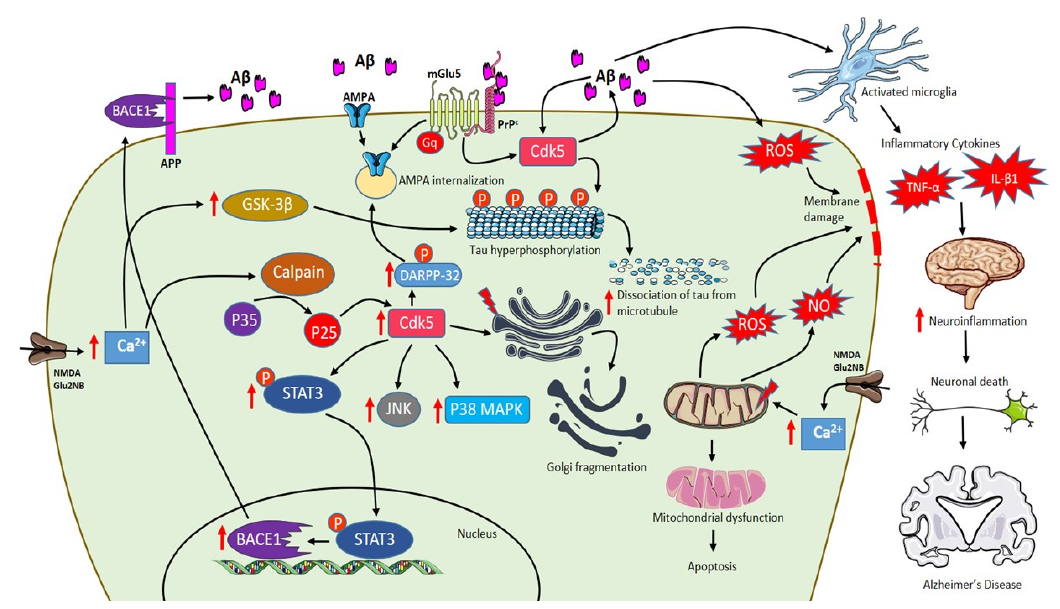
Figure 2. Schematic representation of AD pathophysiology involving A β , extrasynaptic NMDA Glu2NB, mGlu5 and role of activated microglia. Activation of NMDA Glu2NB receptors increases calcium levels inducing p35 to p25 cleavage mediated by calpain and p25 is activates cdk-5 enhancing DARPP-32 phosphorylation eventually leading to AMPA receptor internalization. Increase in A β levels activates Cdk-5 that plays a major role in Golgi fragmentation and tau phosphorylation leading to dissociation of tau from microtubules. Furthermore, Cdk-5 mediates phosphorylation of signal transducer and activator of transcription 3 (STAT3), which increases β -site APP cleaving enzyme 1 (BACE1) transcription resulting in an increase of A β content. Moreover, A β -PrPc-mGlu5 combination leads to AMPA internalization. Excess increase in levels of Ca 2+ in mitochondria results in the generation of reactive oxygen species (ROS) and NO, inhibition of ATP synthesis, mitochondrial permeability transition pore (mPTP) opening, release of cytochrome c, activation of caspases and leading to apoptosis. In addition, A β also initiates a spectrum of neuroinflammation by activating microglia that plays a detrimental role in the expression of pro-inflammatory cytokines like interleukins and tumor necrosis factor- α (TNF- α ) influencing neurodegeneration. (red arrows indicate “increase”).